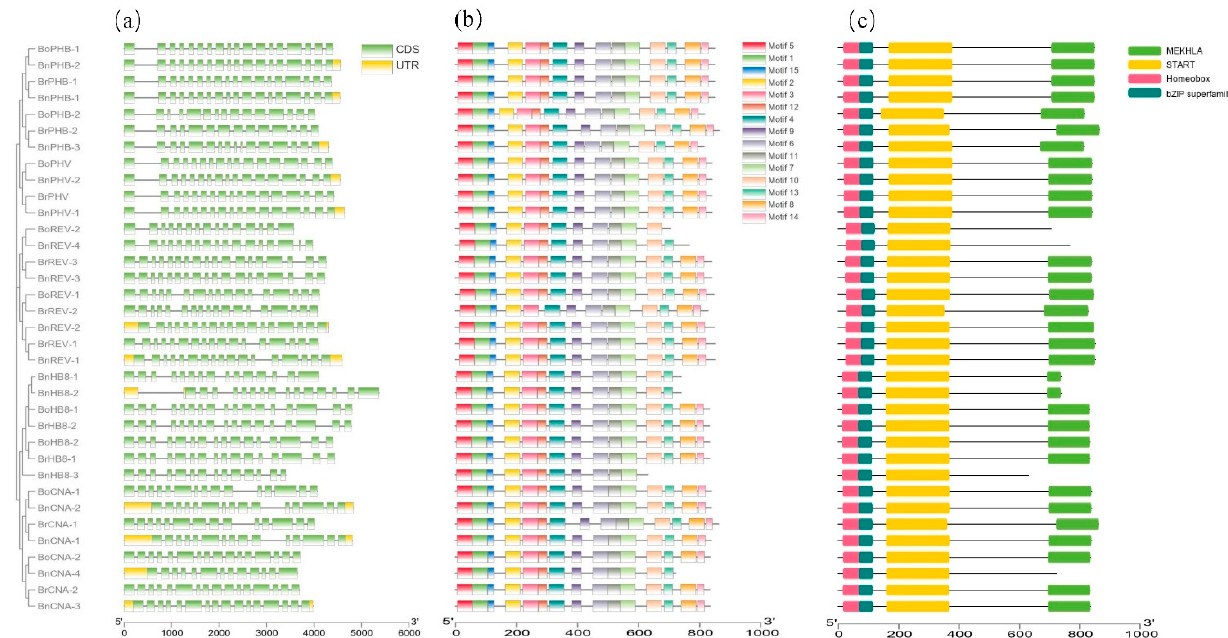
Figure 3. Gene structures, conserved motifs and conserved domains of the HD-ZIP III proteins in B. rapa , B. oleracea and B. napus . ( a ) Intron/exon construction of the HD-ZIP III genes. Green boxes, yellow boxes and black lines indicate exons, untranslated regions and introns, respectively. ( b ) Distribution of the 15 conserved motifs of HD-ZIP III proteins. ( c ) Distribution of the four conserved domains of the HD-ZIP III proteins.